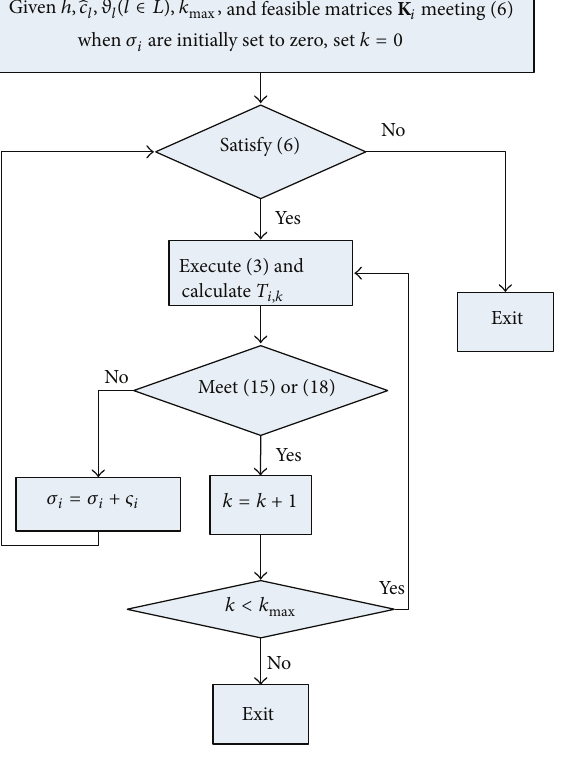
Figure 3: Flow chart of the proposed algorithm. Table 1: Comparison with constant sampling.